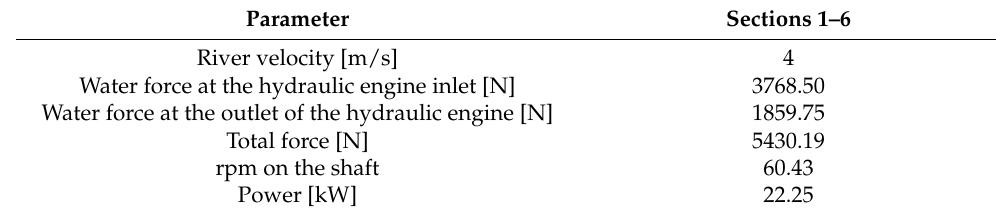
Table 2. Results of numerical calculations of volume-sectional hydraulic